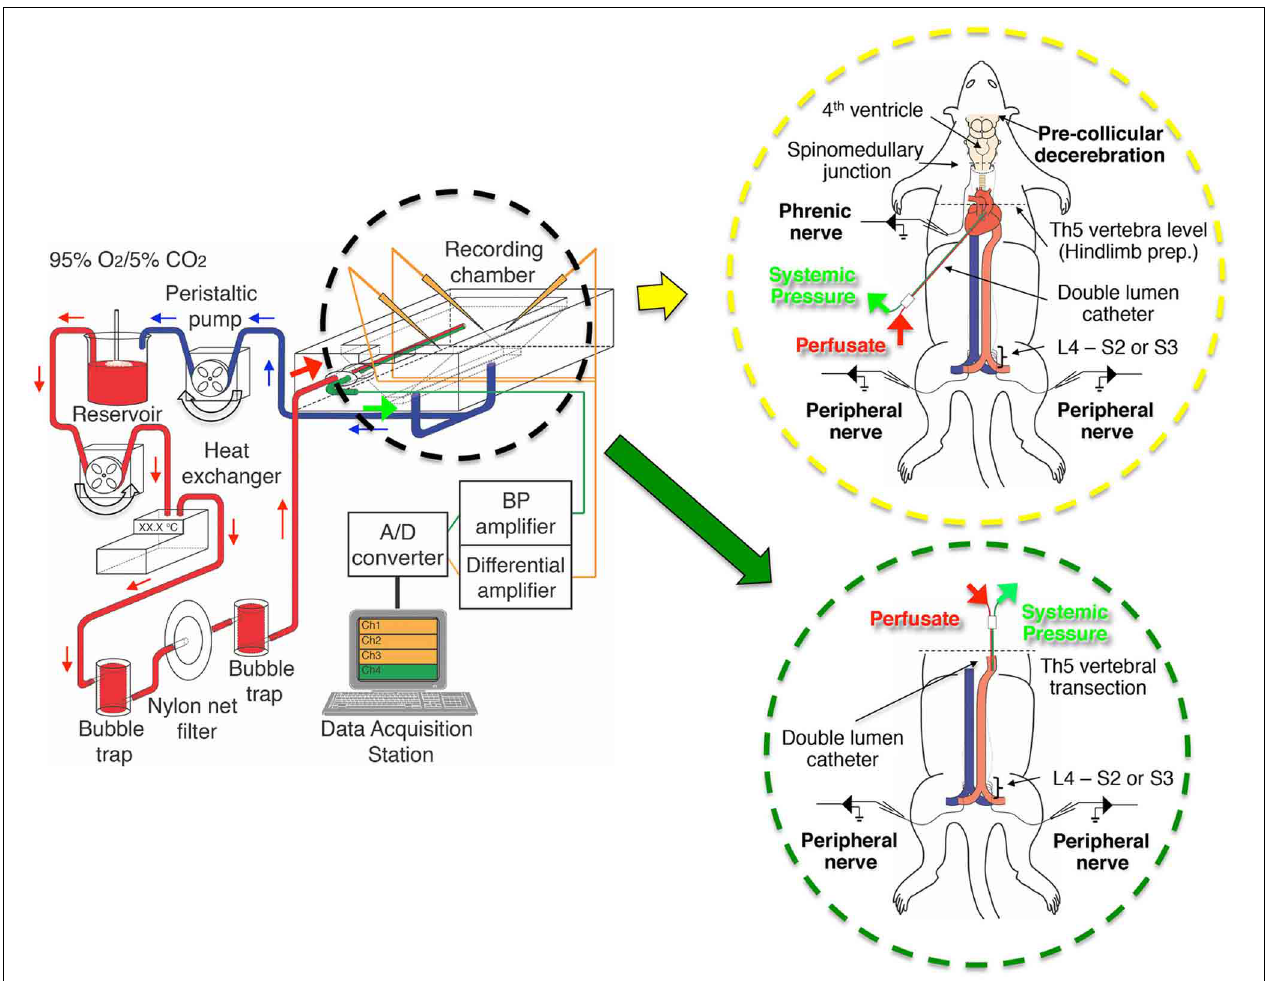
FIGURE 1 | The setup of the perfusion circuit used for electrophysiological recordings from the decerebrate and arterially perfused in situ mouse preparation. The perfusate was circulated from the reservoir to the perfusion circuit with a peristaltic pump, transfused into the aortic arch of the preparation through bubble traps and net filters (nylon net pore size, 20 µ m), and then recycled from the recording chamber back to the reservoir. The inset in the yellow circle is a schematic of a decerebrate and arterially perfused in situ mouse preparation in which a double-lumen